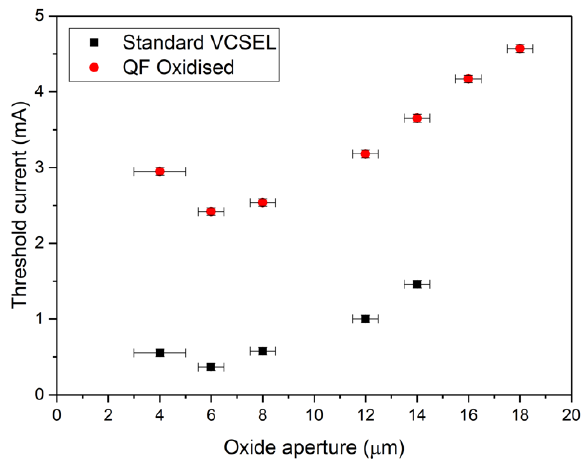
Figure 2. Threshold currents of standard VCSELs and oxidised QF VCSELs.